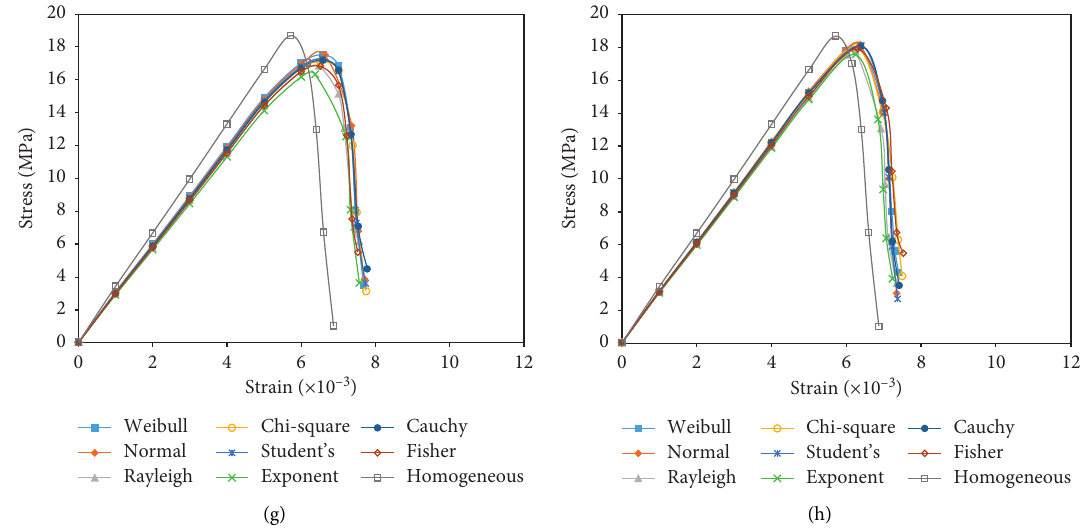
Figure 9: Stress-strain curves of No. 12 coal specimen under nonuniform cohesion distribution in the model with eight different scatter intervals: (a) cohesion interval of 0.82–8.82 MPa, (b) cohesion interval of 1.32–8.32MPa, (c) cohesion interval of 1.82–7.82 MPa, (d) cohesion interval of 2.32–7.32MPa, (e) cohesion interval of 2.82–6.82 MPa, (f) cohesion interval of 3.32–6.32MPa, (g) cohesion interval of 3.82–5.82MPa, and (h) cohesion interval of 4.32–5.32MPa.